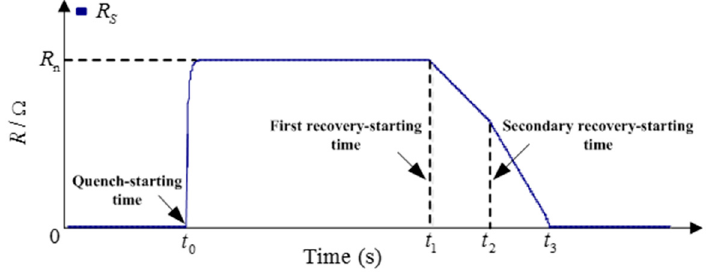
Figure 7. Quench/recovery of the superconducting coil used in the SFCL.